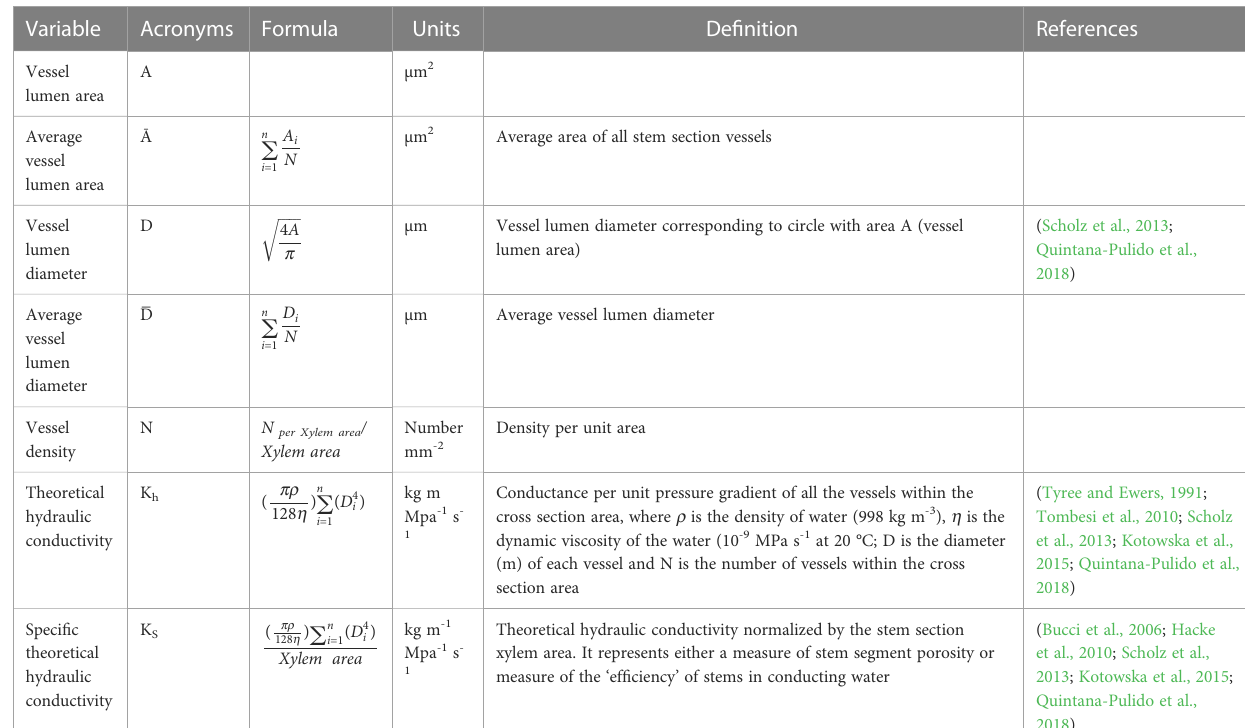
TABLE 1 Hydraulic parameters measured and calculated with acronyms, units, main de fi